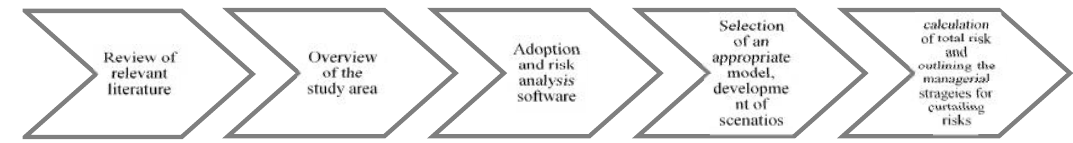
Fig. 1: Data collection and analysis through